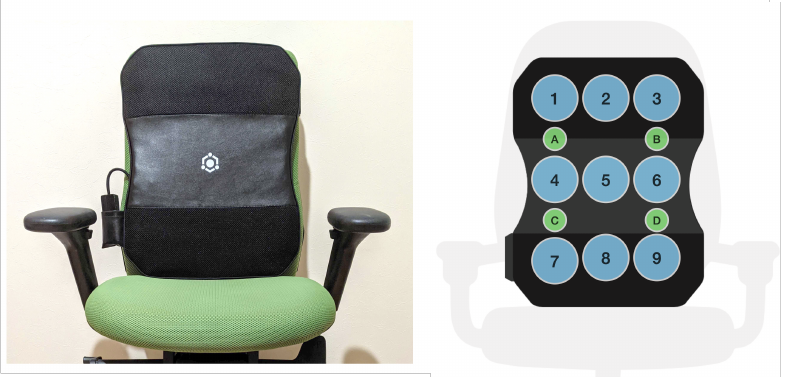
Figure 2. Front view of the LifeChair interface ( left ) and the LifeChair sensor layout (1 to 9) ( right ).